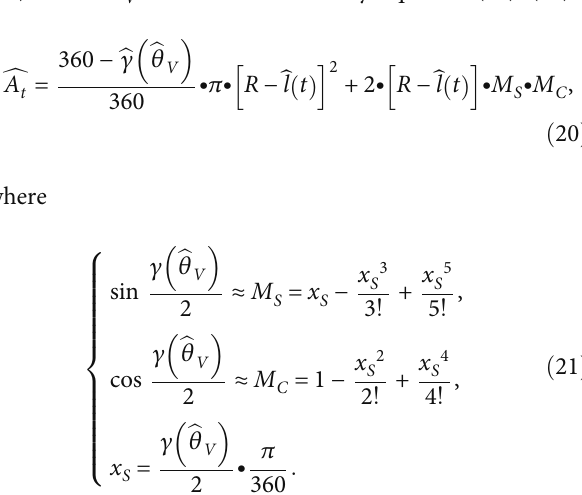
Figure 20: Fit to γ ð θ : Þ .